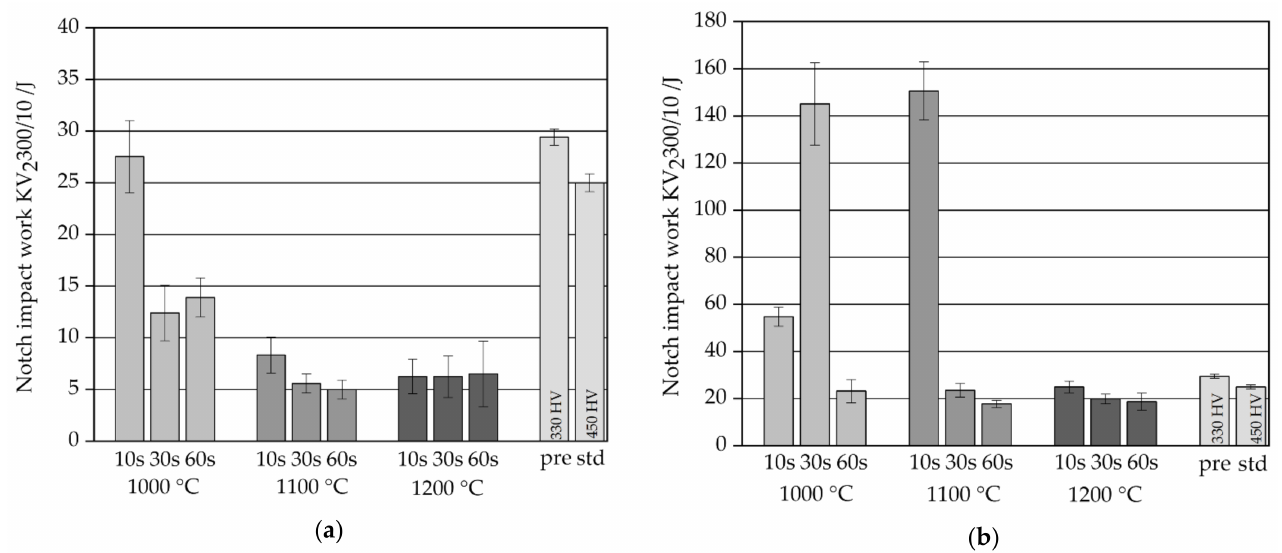
Figure 9. Measured values of the notch impact work at room temperature according to the DIN EN ISO 148 standard in the upper layer ( a ) and in the lower layer ( b